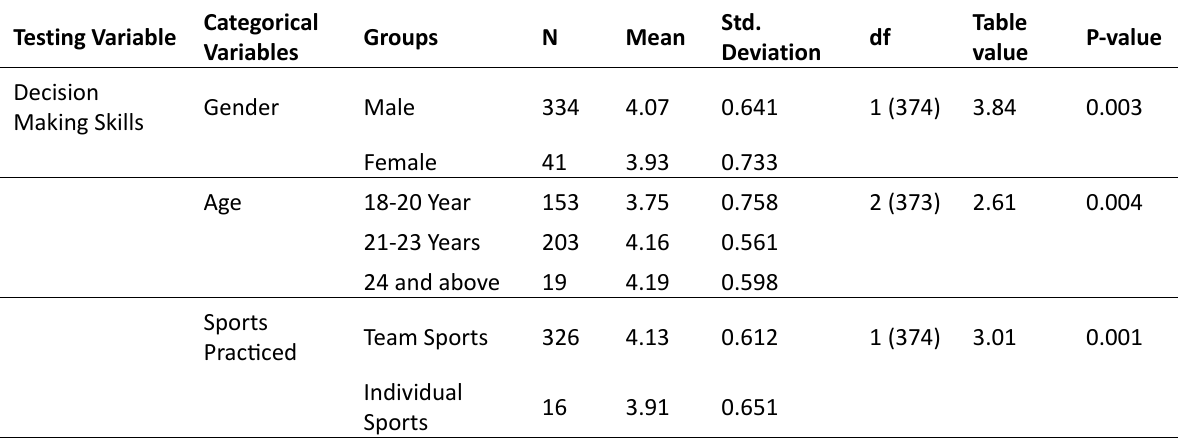
Table 5. ANOVA table showing a significant difference in decision-making skills developed through sports between male and female